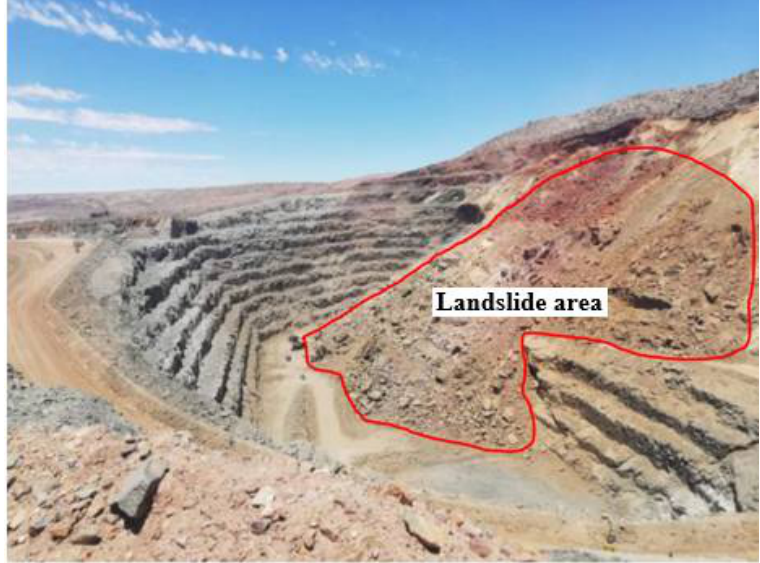
Figure 14. Image of Gamsberg mine landslide (Adapted from [110]).